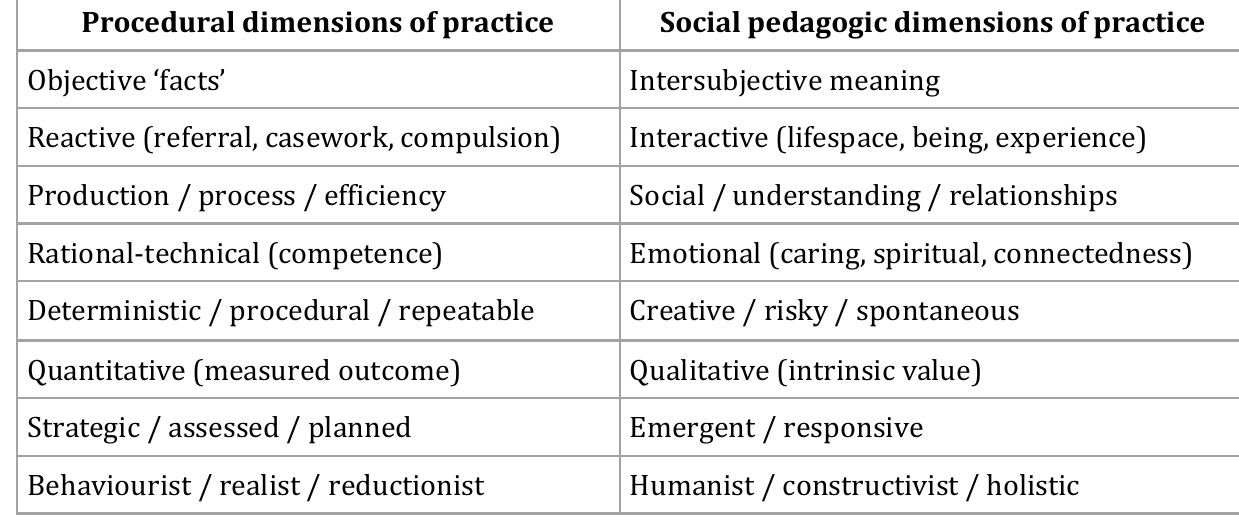
Table 1: Differentiating procedural from social pedagogic dimensions of professional practice Procedural dimensions of